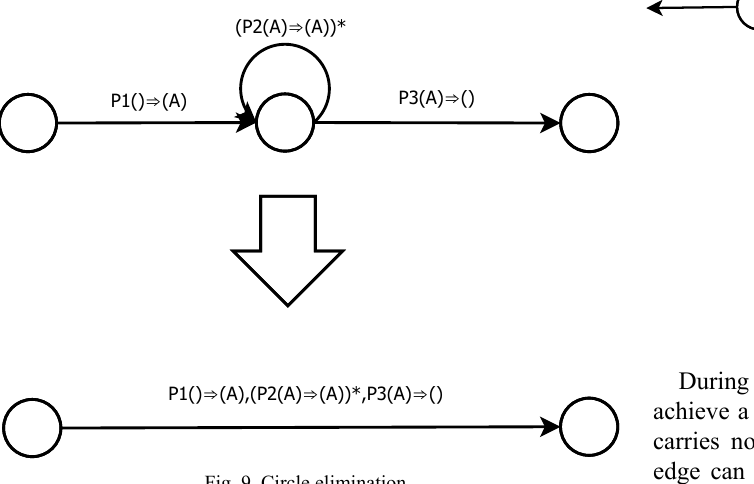
Fig. 9. Circle elimination.